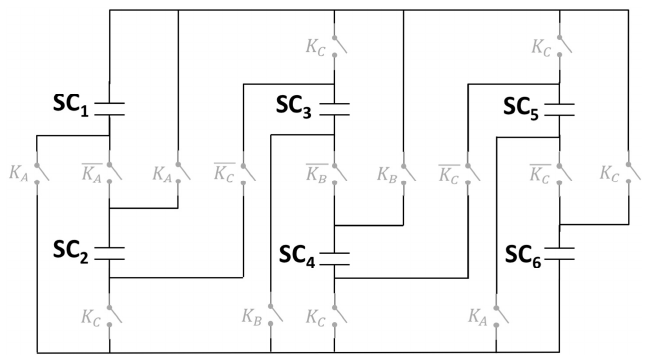
Figure 5. Proposed series/parallel changeover circuit for storage bank.